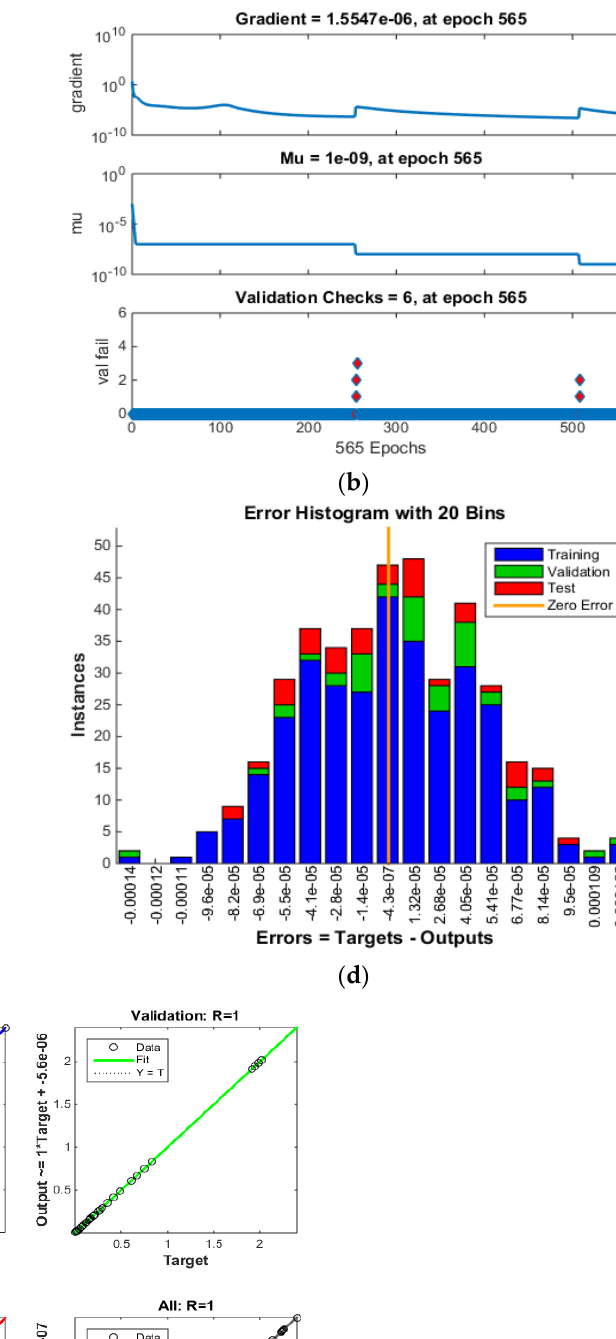
Figure 4. Graphic representation for LMT-ABPNN base on variants of 𝛽 for 𝑓′(𝜂) of MHD-SGFM. ( a ) MSE representa- tion, ( b ) Results of the transition state, ( c ) Fitness of the curve, ( d ) Histogram for error analysis, ( e ) Regression.